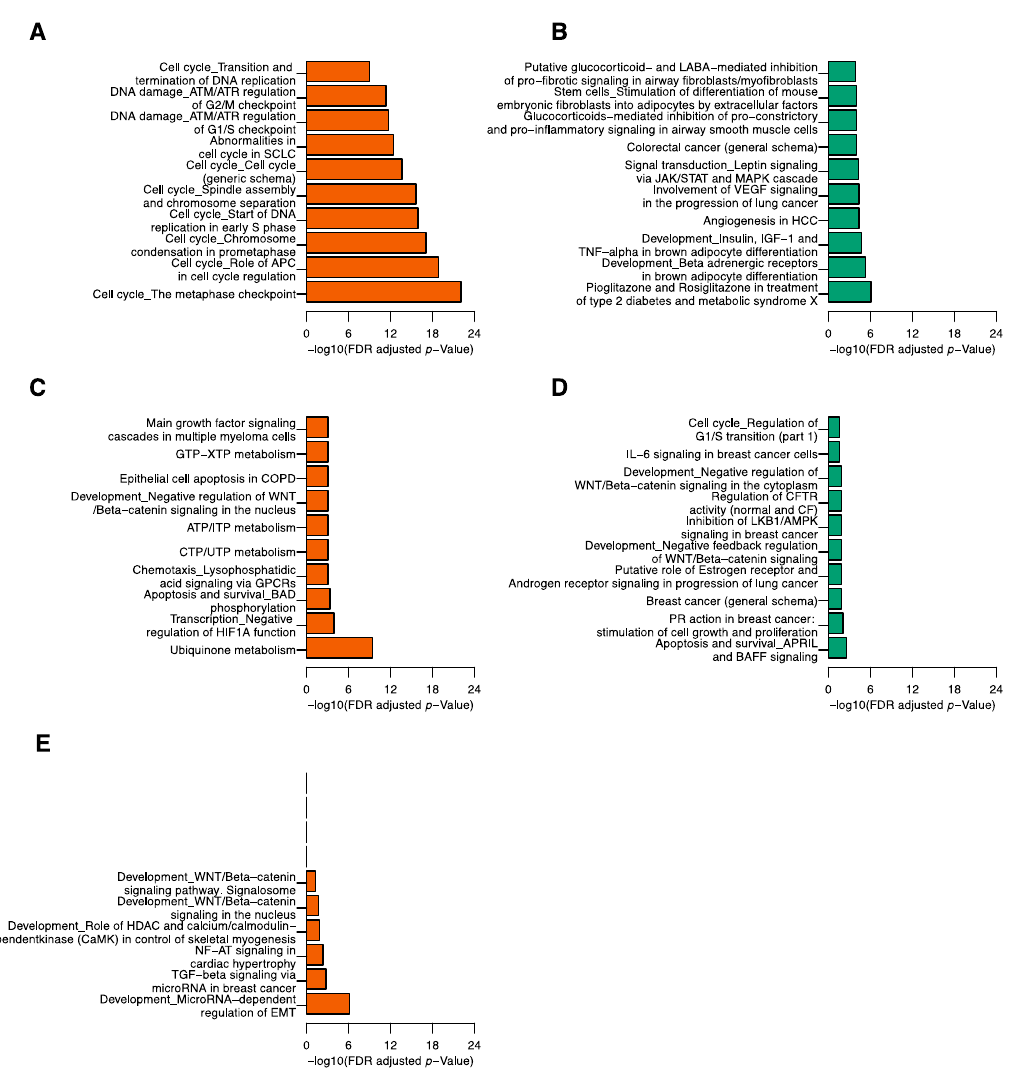
Figure 4. Top pathways of gene modules associated with tRFs. Top 10 pathways enriched in pink ( A ), yellow ( B ), blue( C ), black ( D ), and green-yellow ( E ) modules.